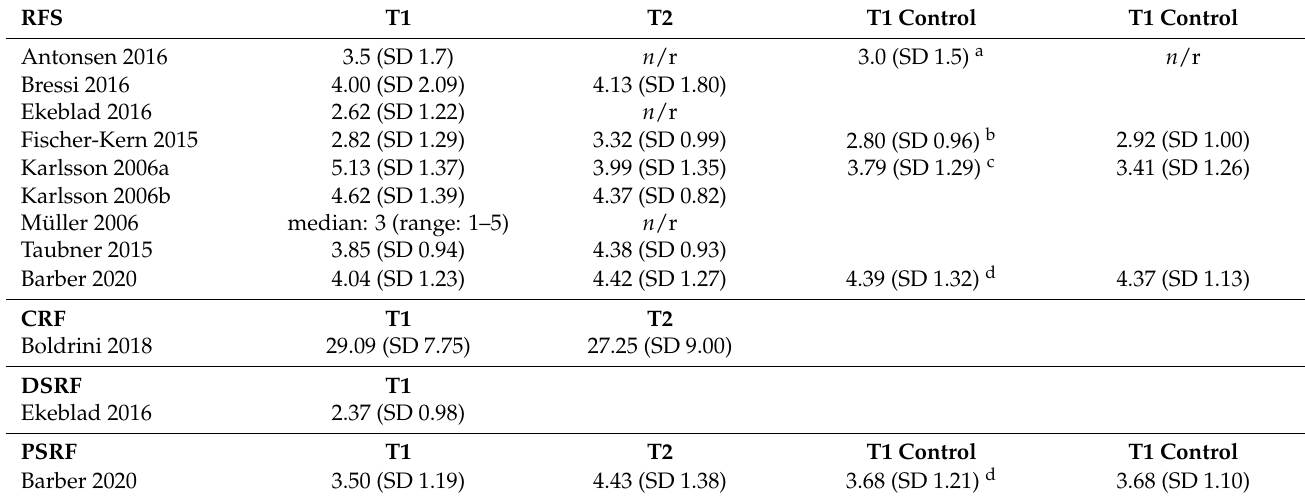
Table 2. Mentalization scores and